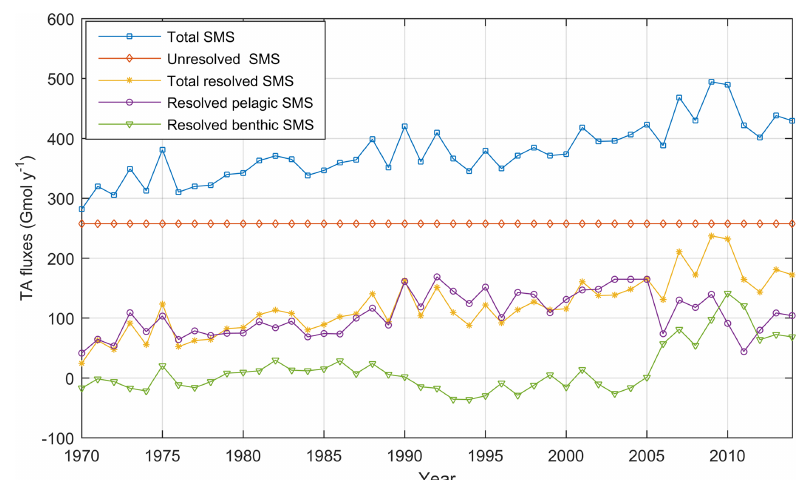
Figure 7. Annual mean TA sources minus sinks (SMS) (Gmolyr − 1 ) in the entire Baltic Sea according to BALTSEM calculations: Resolved benthic sources minus sinks (SMS) (green line), resolved pelagic SMS (purple line), total resolved SMS (yellow line), unresolved SMS (red line), and total SMS (blue